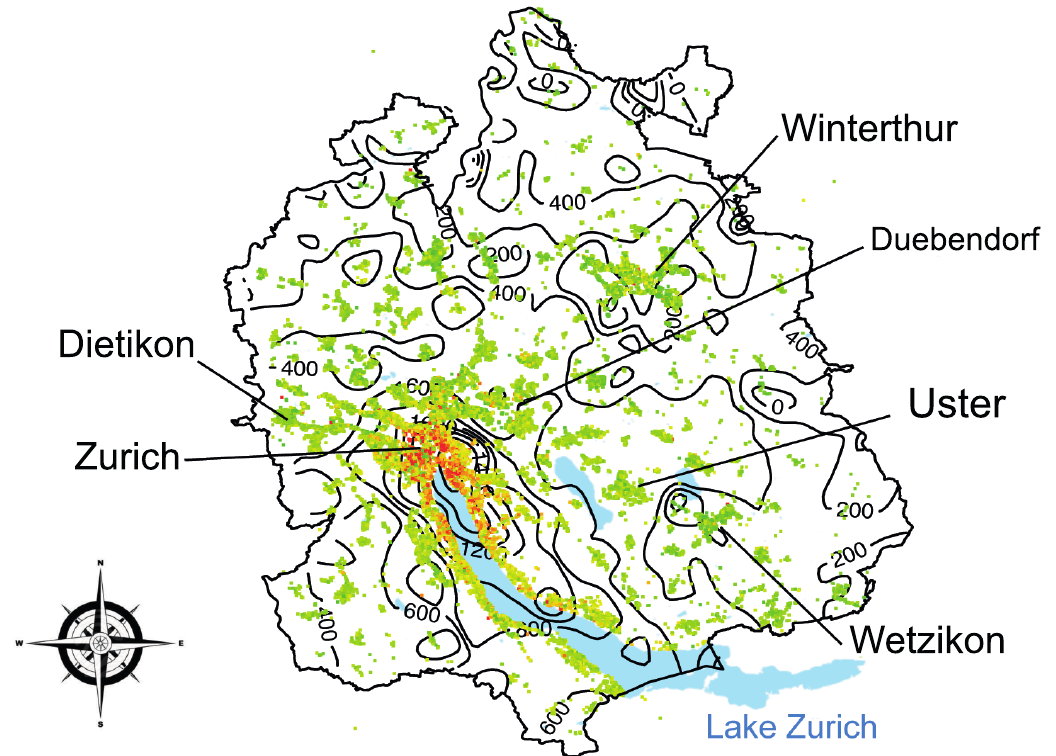
Figure 4. Nonparametric estimates of predicted land values. (This figure shows the estimation results for the land value surface based on smoothed predicted (implicit) land values. In the nonparametric local regression, land price predictions are regressed Swiss Grid coordinates. The estimation is based on the Nadaraya–Watson local constant estimator. The isolines correspond to land value estimates. Note that the Nadaraya–Watson estimates, which are located close to the boundary and outside the map, are not consistent and do not allow for an economic